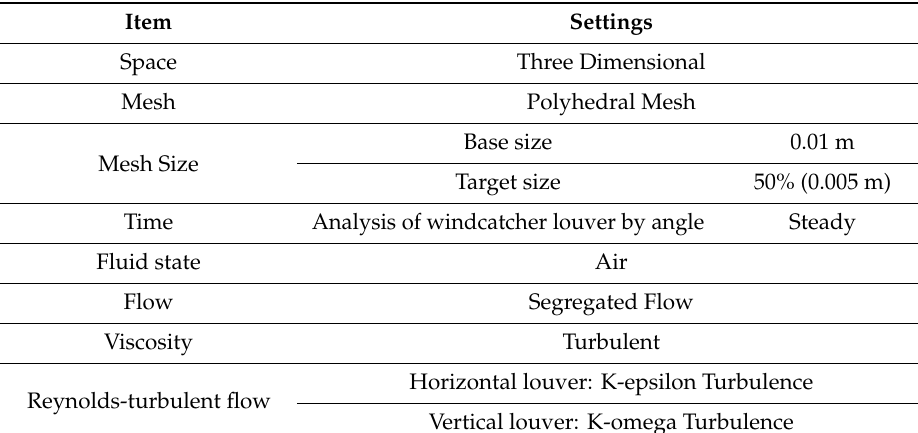
Table 2. Simulation